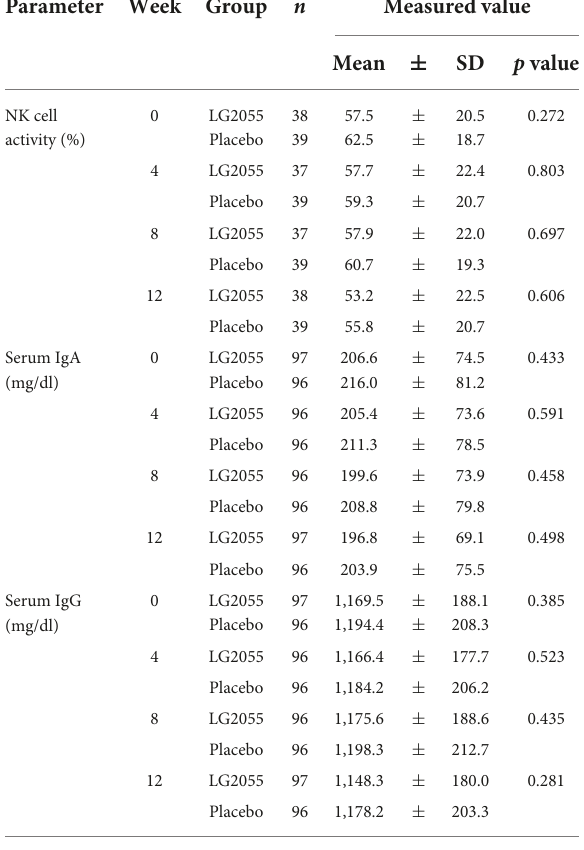
TABLE 6 Measured values of the immune markers during the intake